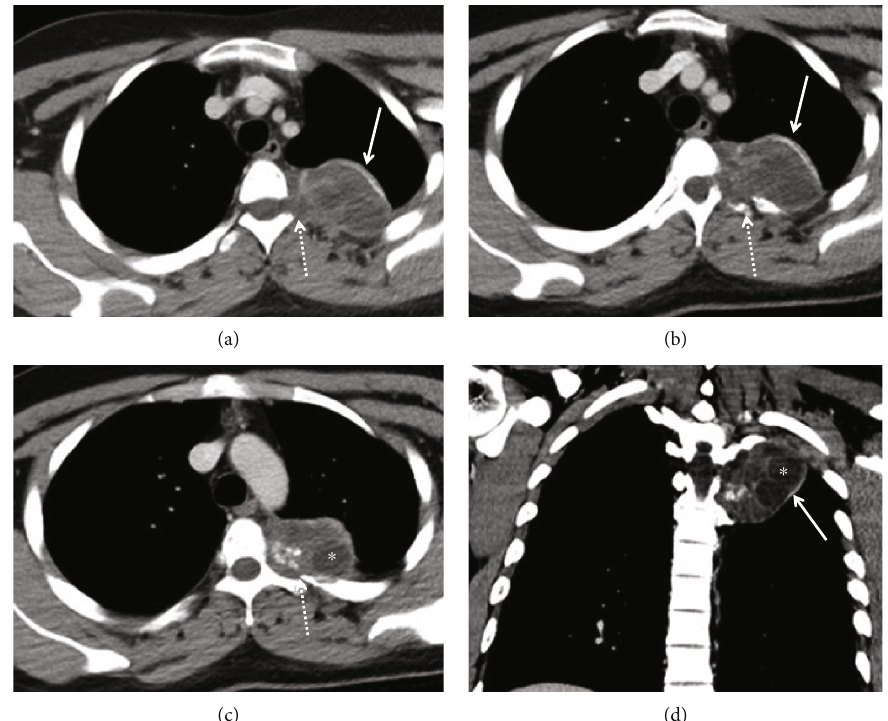
Figure 1: Axial (a – c) and coronal (d) images of contrast-enhanced CT exam show a left upper paravertebral cystic mass (arrows) with daughter cysts (asterisks), peripheral and intrinsic calci fi cations, adjacent ribs remodeling and erosions, and extension into adjacent left neural foramina (dashed